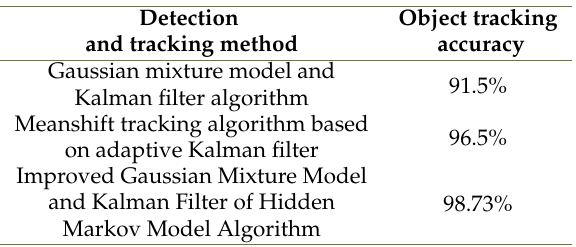
Table 1. Comparison of the effects of three algorithms